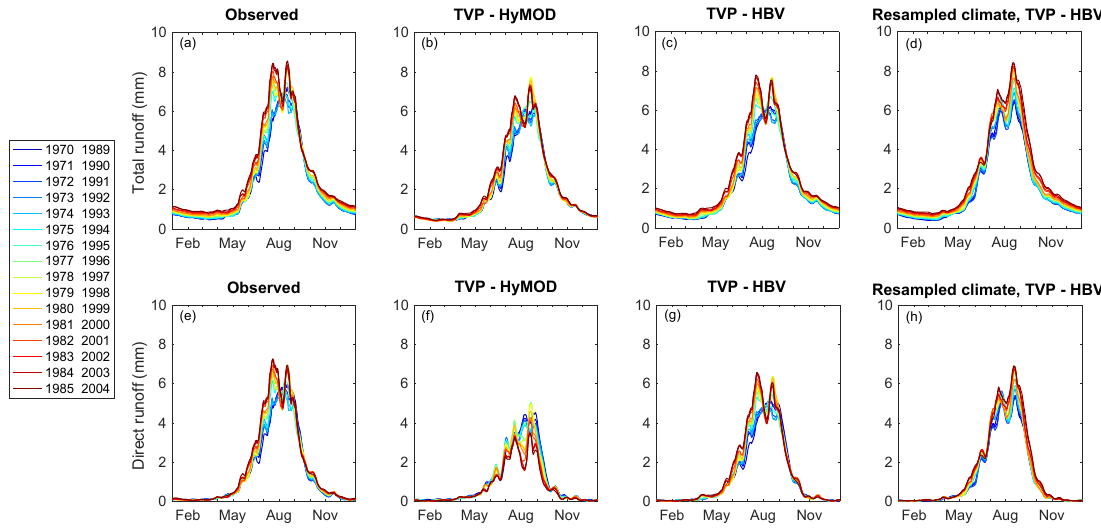
Figure 8. Moving Average over Shifting Horizon (MASH) results for observed streamflow (first column), simulated streamflow from time- varying parameter model (without state DA) for HYMOD (second column), HBV (third column) and resampled climate HBV (fourth column). These are split into total runoff (first row) and direct runoff or surface runoff (second